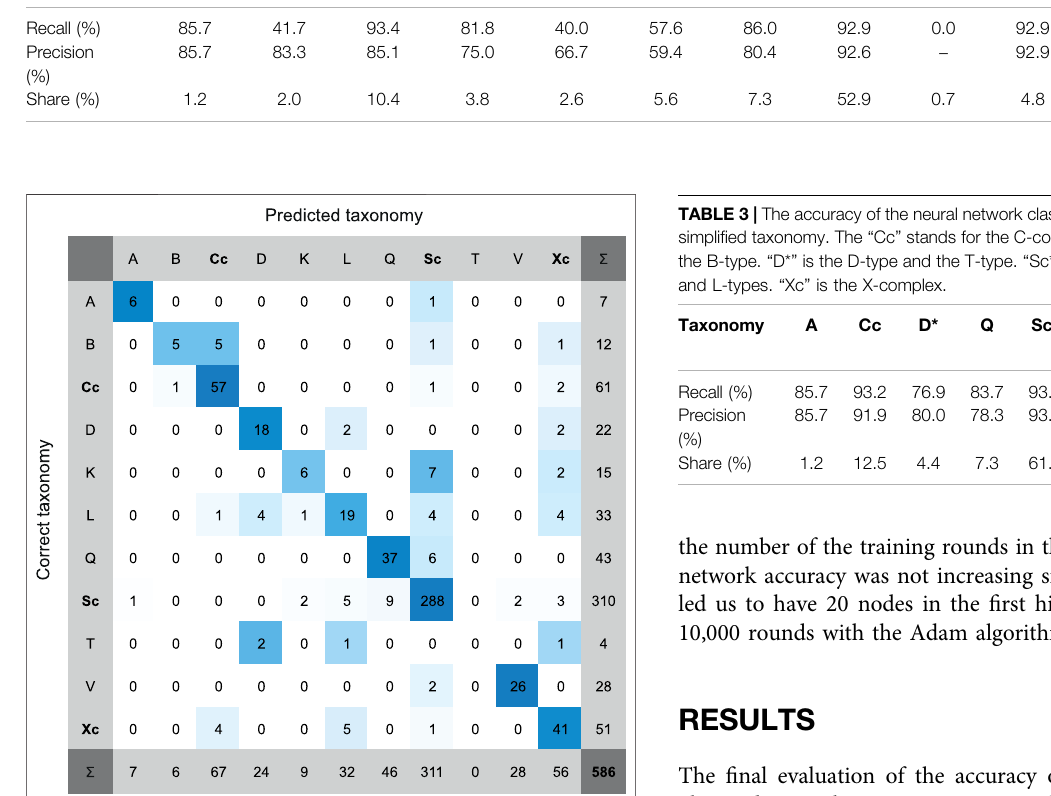
TABLE 2 | The accuracy of the neural network classi fi er per taxonomic type and their share of the data. “ Cc, ” “ Sc, ” and “ Xc ” stand for C, S, and X-complexes. Taxonomy